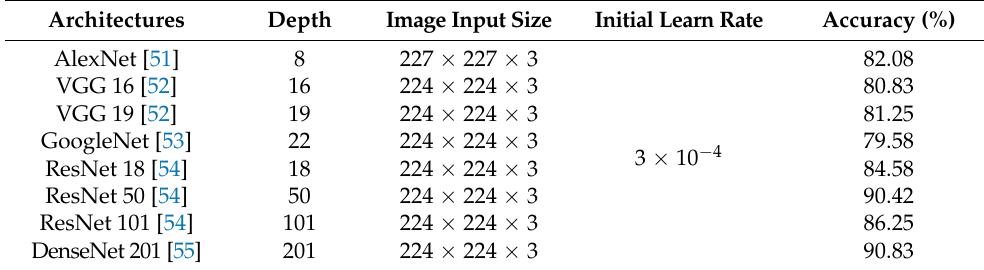
Table 9. Transfer learning